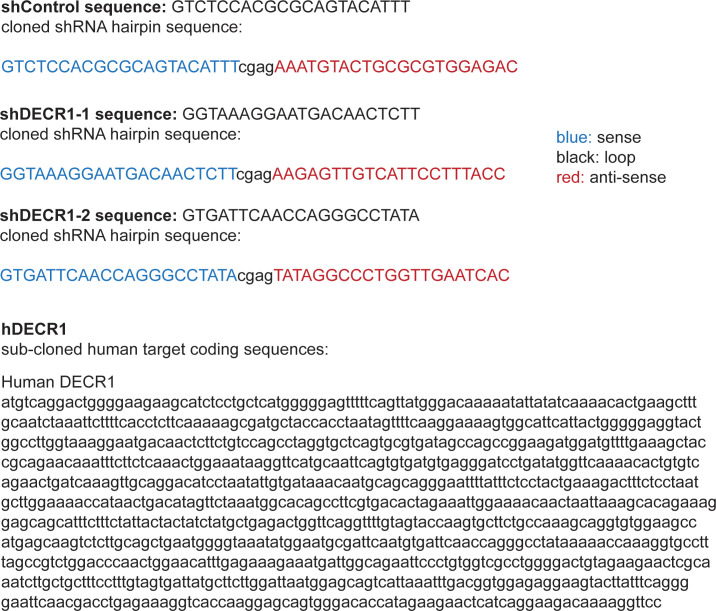
The sequence of the DECR1 shRNA and hDECR1 vectors.